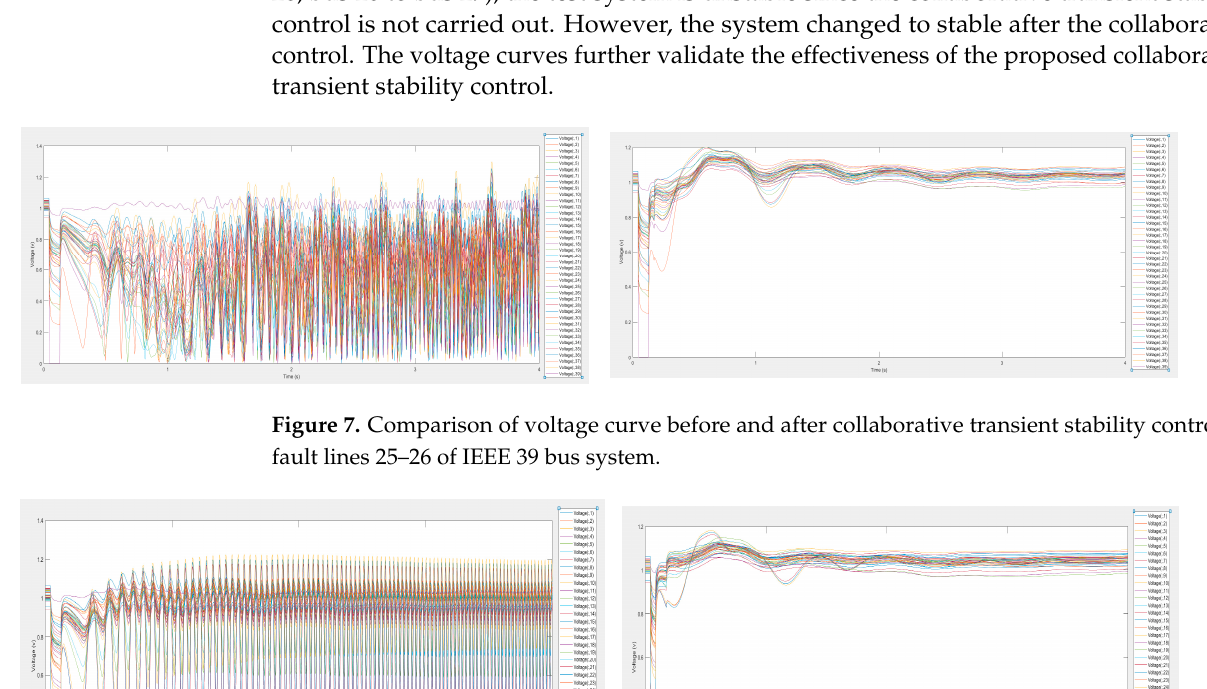
Figure 6. Comparison of rotor angle curve before and after collaborative transient stability control on fault lines 26 − 29 of IEEE 39 bus system.